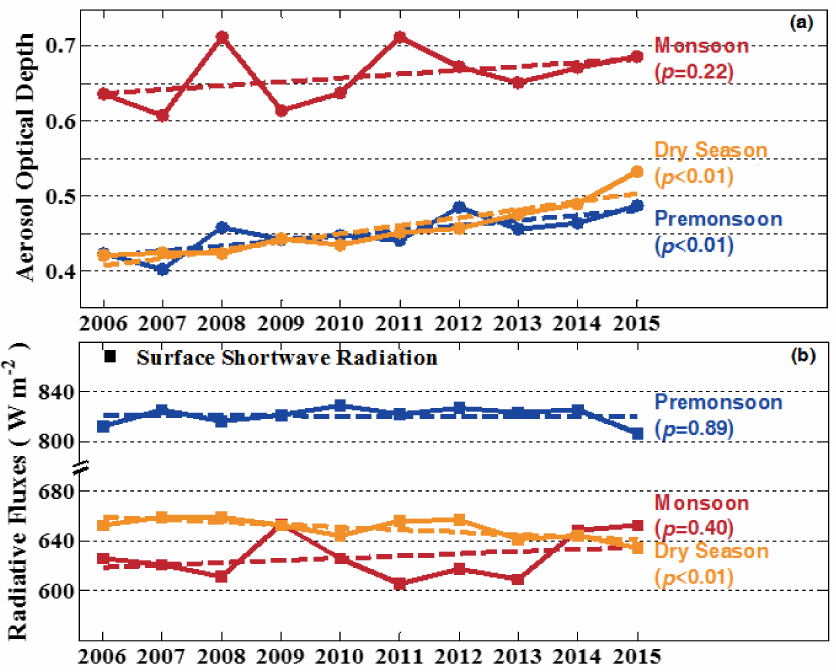
Figure 9. Temporal variations in ( a ) spatial average AOD from MODIS and ( b ) SSR from CERES during the pre-monsoon, monsoon, and dry seasons in South Asia from 2006 to 2015, respectively. The dashed lines indicate the linear fit line of the solid line with the same color; p is the significance